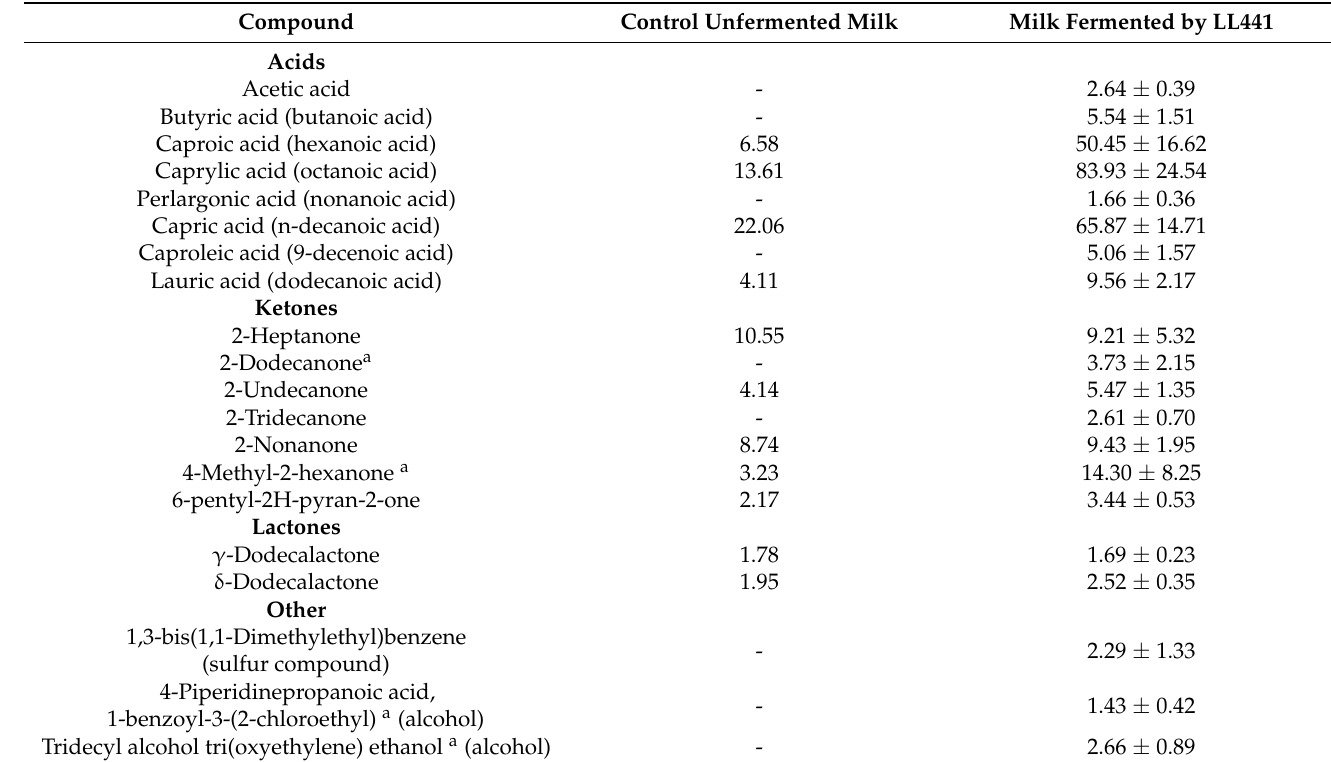
Table 2. Volatile compounds (VOCs) produced by L. plantarum LL441 in